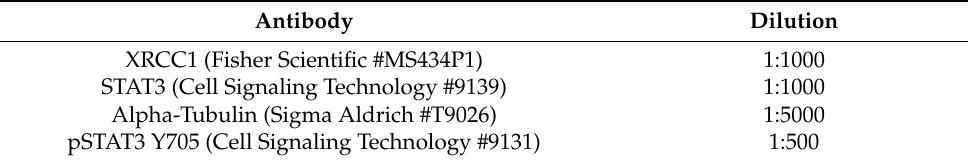
Table 4. Antibodies and dilutions used for immunoblotting